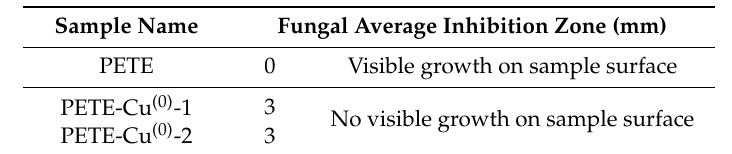
Figure 9. The PETE-Cu (0) composites antimicrobial activity tests against Chaetomium globosum. Inhibition properties of fungal growth on Petri dishes: ( a ) PETE, ( b ) PETE-Cu (0) -1; ( c ) PETE-Cu (0) -2. Table 9. Results of tests on the antifungal activity of PETE-Cu (0) composites, procedure in accordance with the PN EN 14119: 2005 point 10.5 (B2)